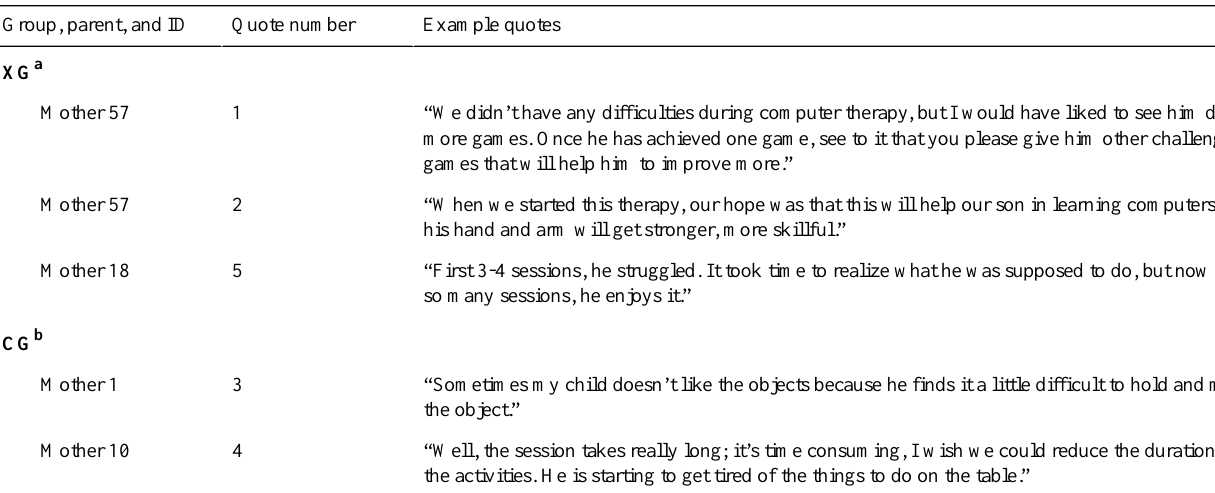
Table 6. Challenges faced by parents.